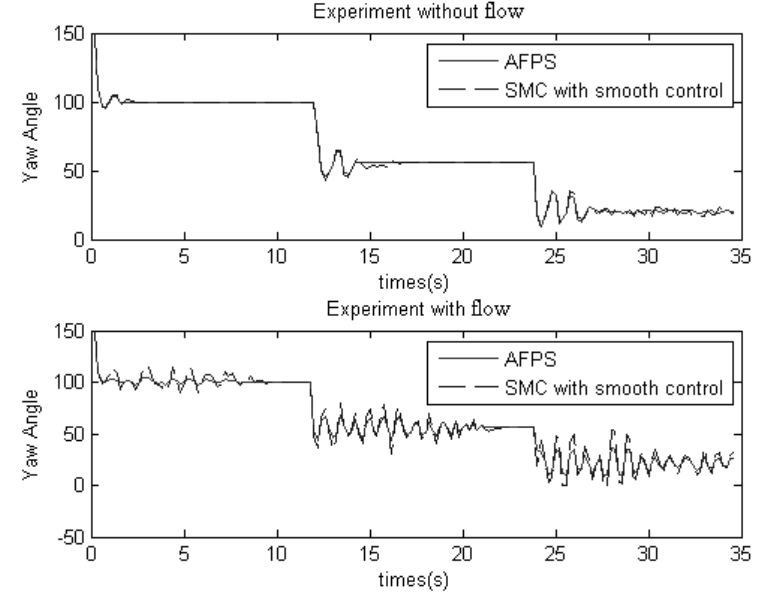
Fig. 5. Controller results comparison between AFPS and SMC with smooth